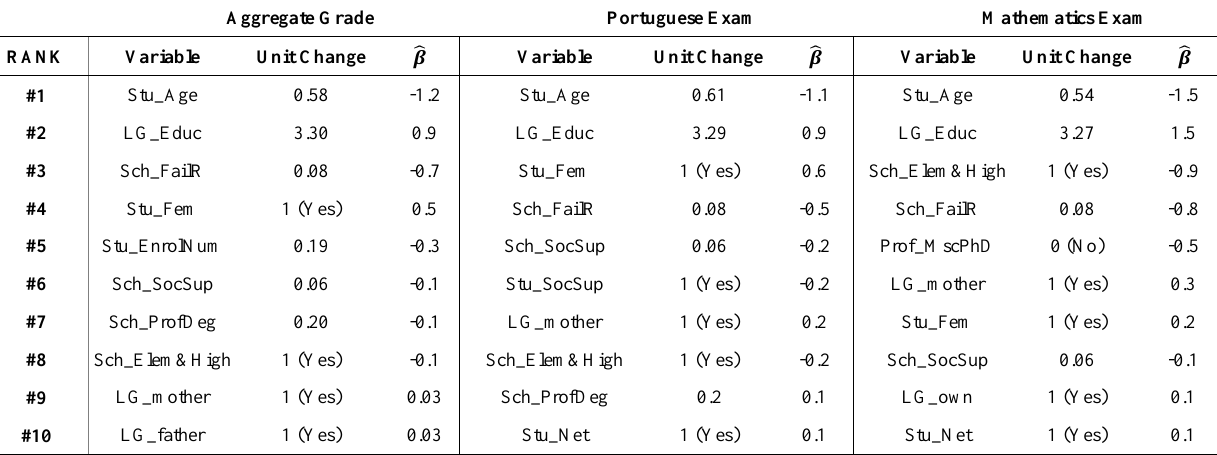
Table 1. Predicted impacts of changing a unit in each variable, ceteris paribus, using prototypes Aggregate